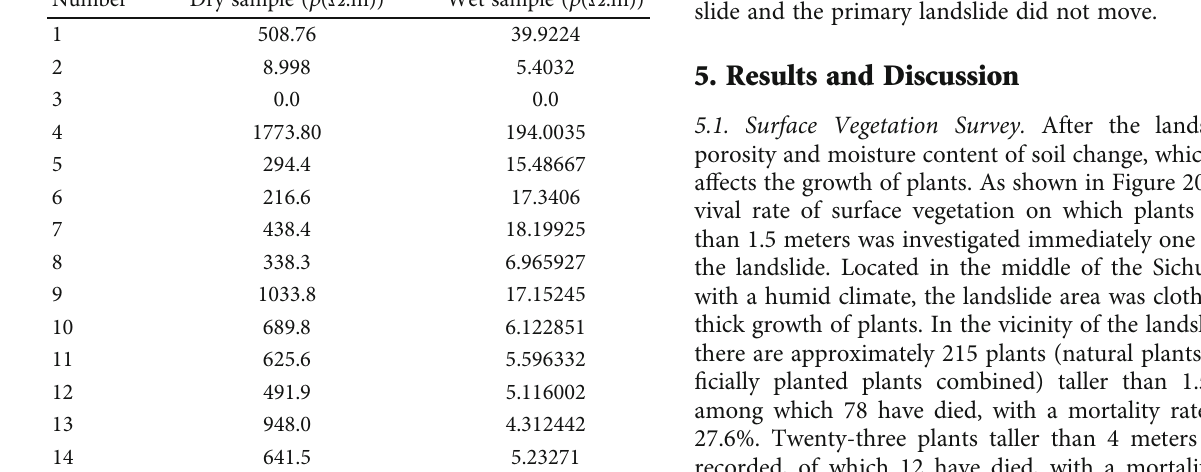
Figure 24: The sample test in the lab. (a) is the measurement of electrical characteristic. (b) is the measurement of rock mechanical parameters. Table 3: The resistivity measurements in the laboratory. Number Dry sample ( ρ ( Ω